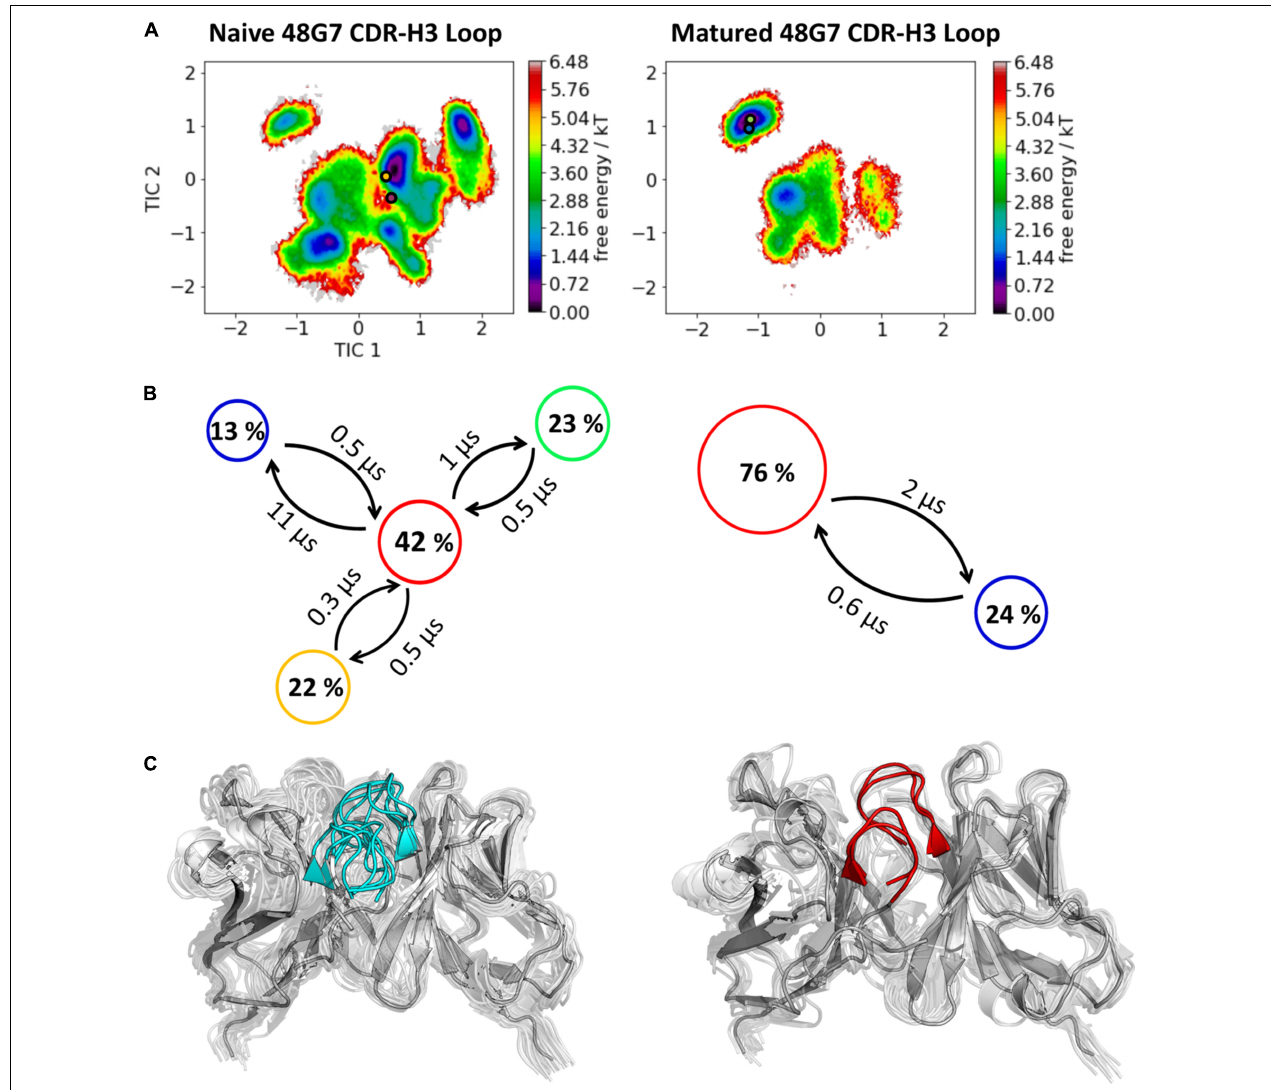
FIGURE 6 | Kinetic, thermodynamic and structural analyses of the CDR-H3 loop ensemble in solution upon affinity maturation. (A) Free energy surface of the naive and matured 48G7 Fab in the same coordinate system, including the respective X-ray structures crystallized with and without antigen. The orange and green dots show the bound X-ray structures of the naïve and the matured Fab, respectively, while magenta and blue display the X-ray structures crystallized without antigen. (B) Transition timescales between the different macrostates orientated according to the tICA space including the state probabilities. (C) Substantial decrease of the conformational ensemble of the 48G7 antibody upon affinity